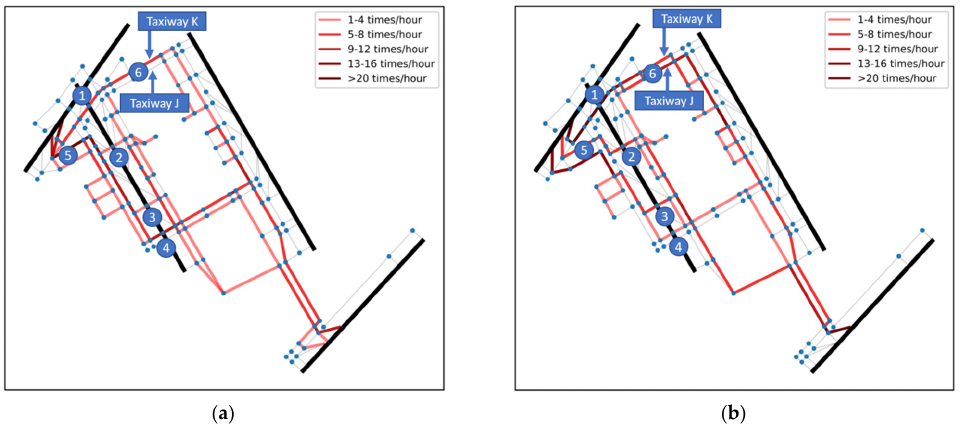
Figure 13. Taxiway usage frequency map of landing aircraft. ( a ) Observed data. ( b ) Optimized result.